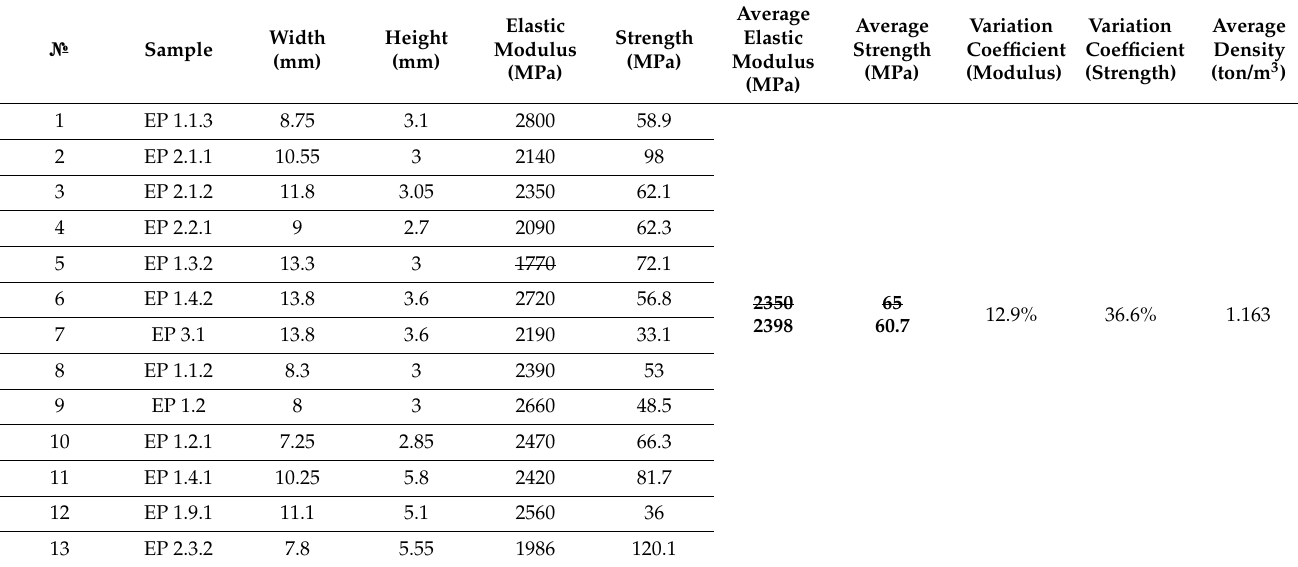
Table A25. Results of three-point bending tests at 23 ◦ C with unfilled binder (EP1, EP2).